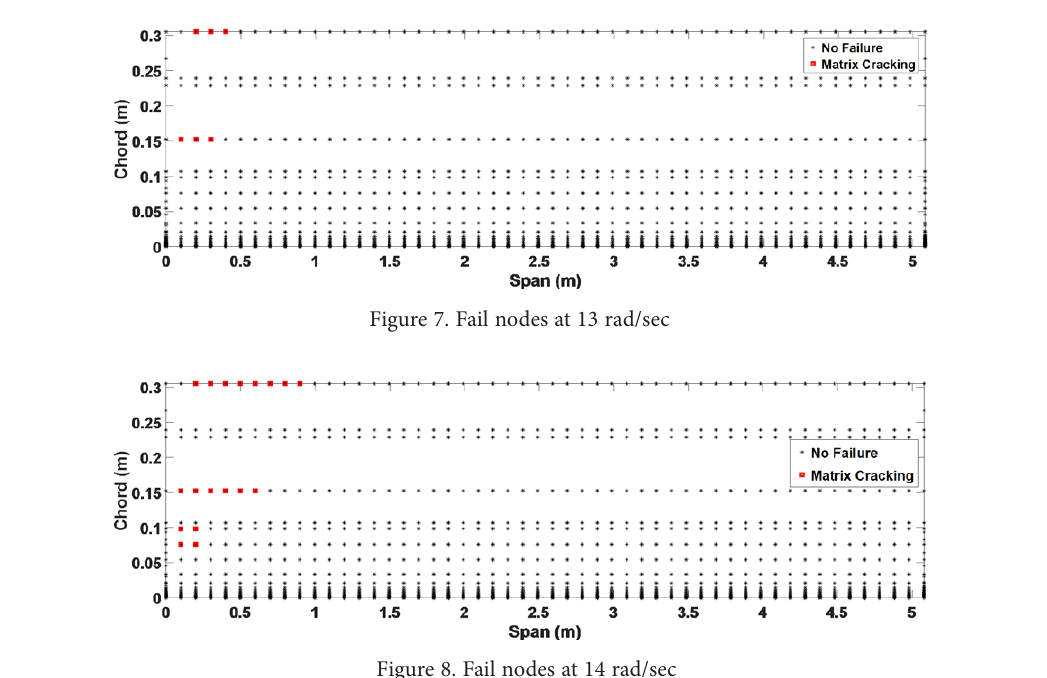
Figure 8. Fail nodes at 14 rad/sec